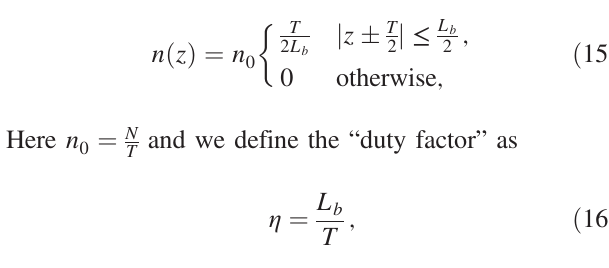
FIG. 3. (Top) beam longitudinal distribution n ð z Þ , (middle) relative energy loss due to the wakefields δ relative energy loss after compensating the energy change of the two bunch centers by adjusting the rf chirp. Here we adopt ffiffi p 3 η ¼ 6